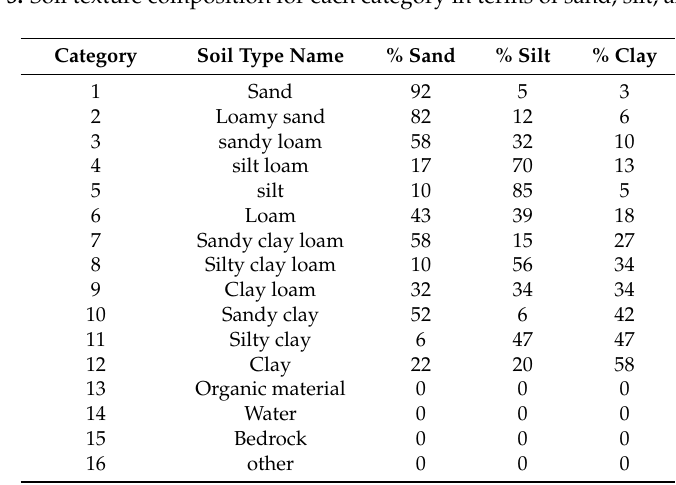
Table 5. Soil texture composition for each category in terms of sand, silt, and